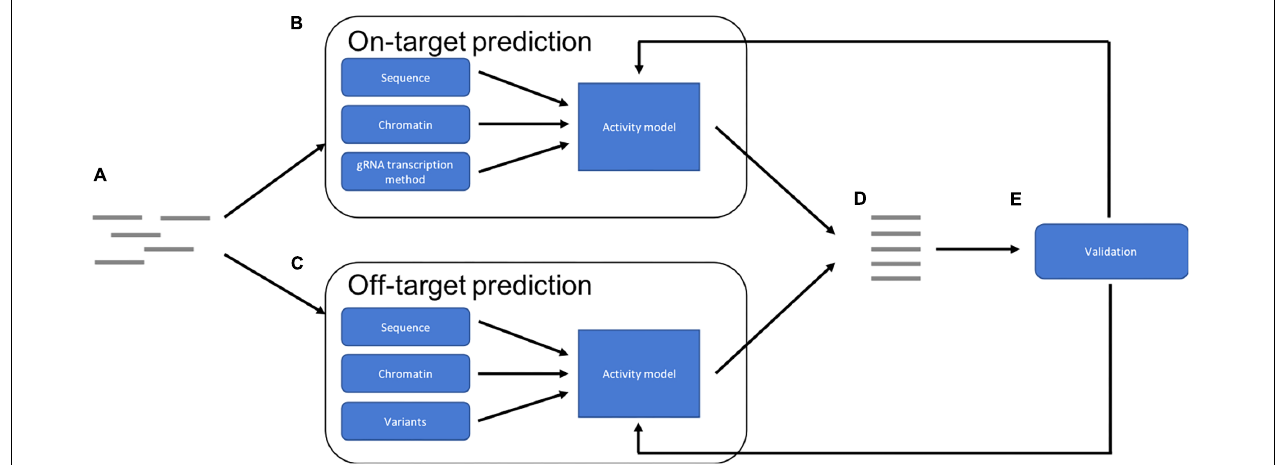
FIGURE 1 | Overview of an optimal prediction pipeline: (A) potential target sites are identified. (B) On-target activity is predicted using a combination of target sequence, chromatin features and gRNA transcription method. (C) Off-target activity is predicted using a combination of sequence and chromatin features while also taking sequence variations into account. (D) The results are combined and then a ranked list of optimal targets can be provided. (E) The predictions can be validated experimentally and then used to improve accuracy of the models, improving future predictions.